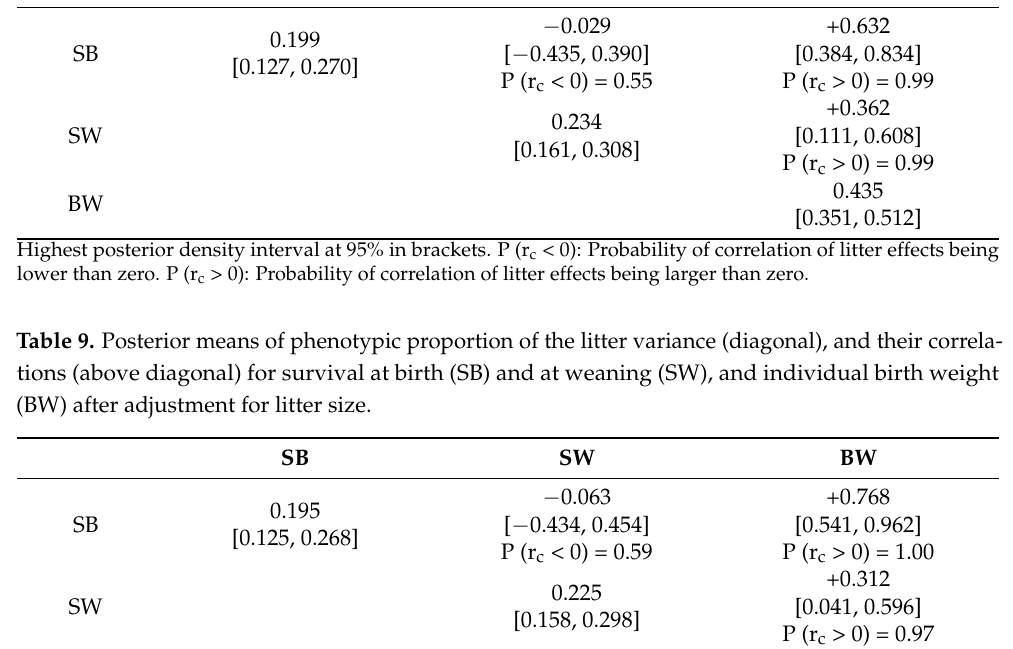
Table 8. Posterior means of phenotypic proportion of the litter variance (diagonal), and their cor- relations (above diagonal) for survival at birth (SB) and at weaning (SW), and individual birth weight (BW). SB